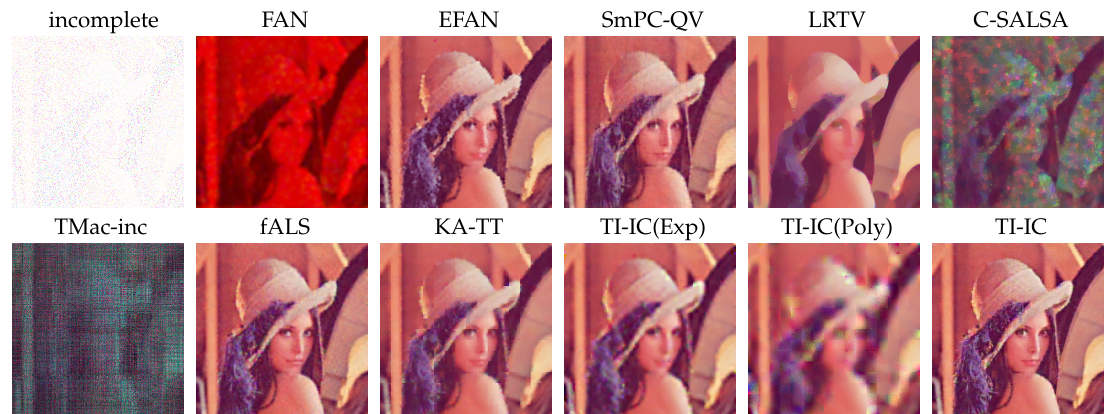
Figure 3. Test B (95% randomly missing entries in the incomplete tensor) for the image “Lena”.